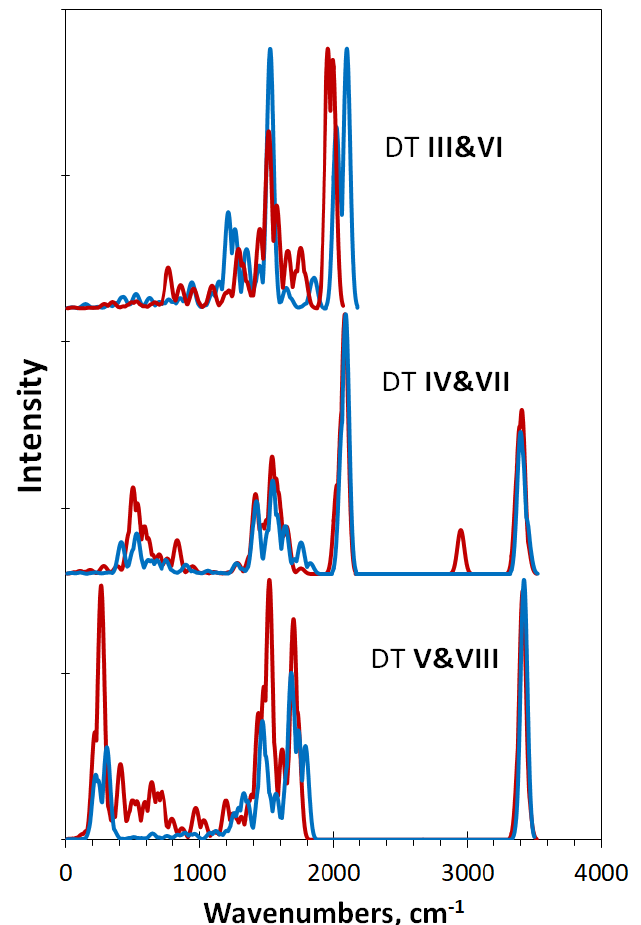
Figure 5. The virtual one-phonon IR absorption spectra of DTs III – V (red) and VI – VIII (blue). The Gaussian convolution of the original stick bars performed with a FWHM of 60 cm −1 . UHF AM1 calculations.